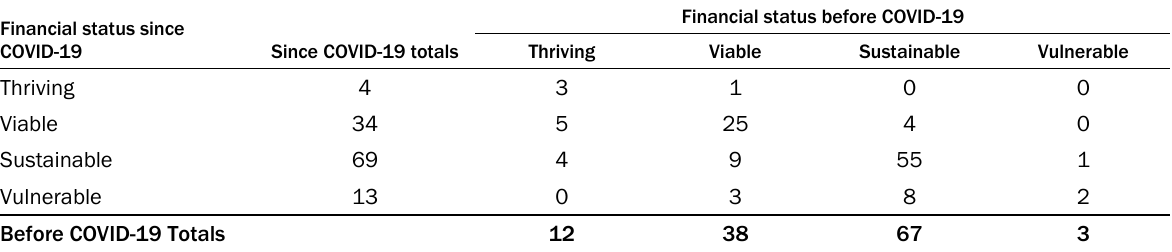
Table 3. Comparison of Financial Status Before and Since